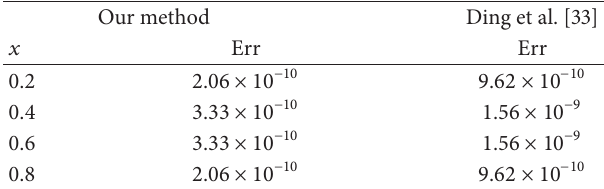
Table 7: Results, with 𝜔 = 𝜋 , for Example